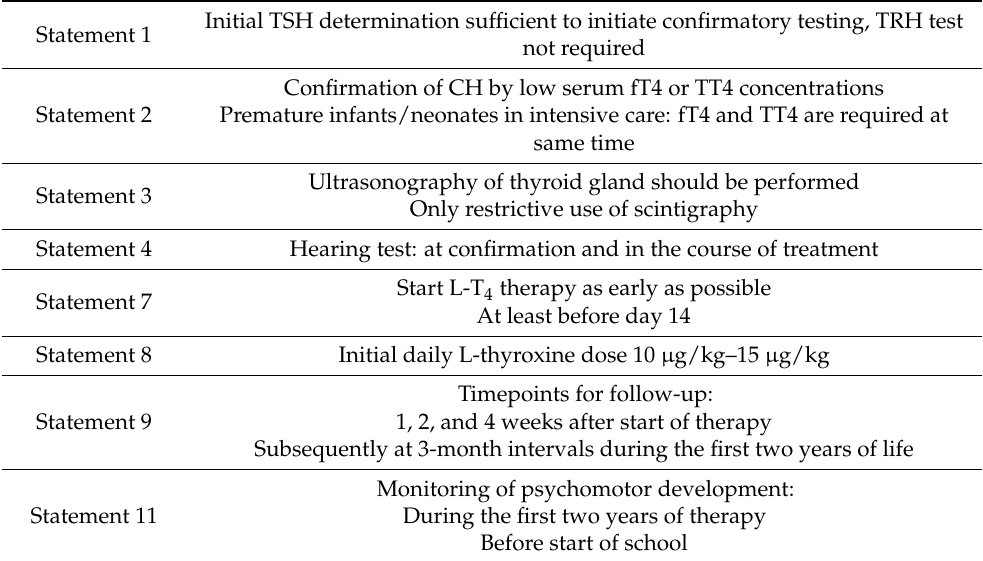
Table 1. Excerpt of statements included in the German Guideline for Primary Congenital Hypothy- roidism (CH)